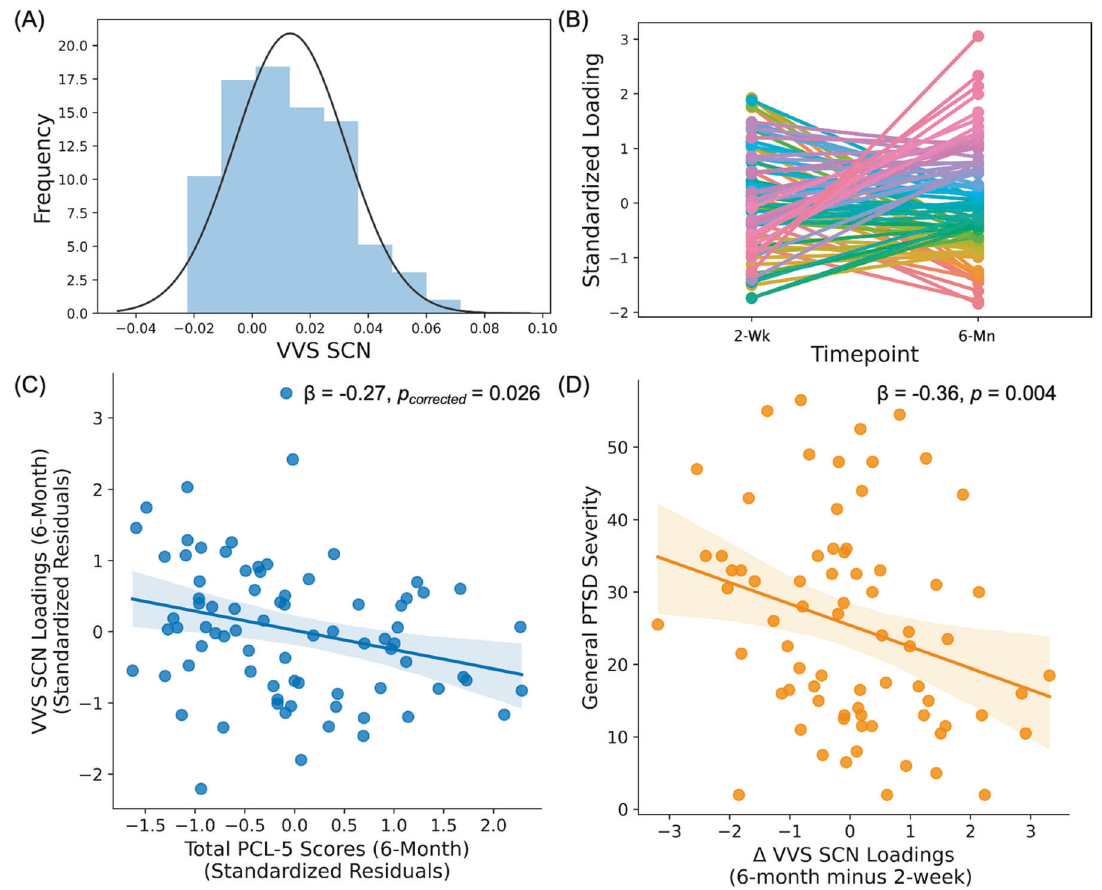
between timepoint 1 (i.e., 2 weeks) and timepoint 2 (i.e., 6 months) post-trauma ( B ). The component loadings at 6 months were related to total scores on the PTSD Checklist for DSM-5 (PCL-5) at 6 months in models described in the “ Methods ” section ( C ). Participants who showed an represent the linear line of best fi t and the shaded bar represents the 95% con fi dence